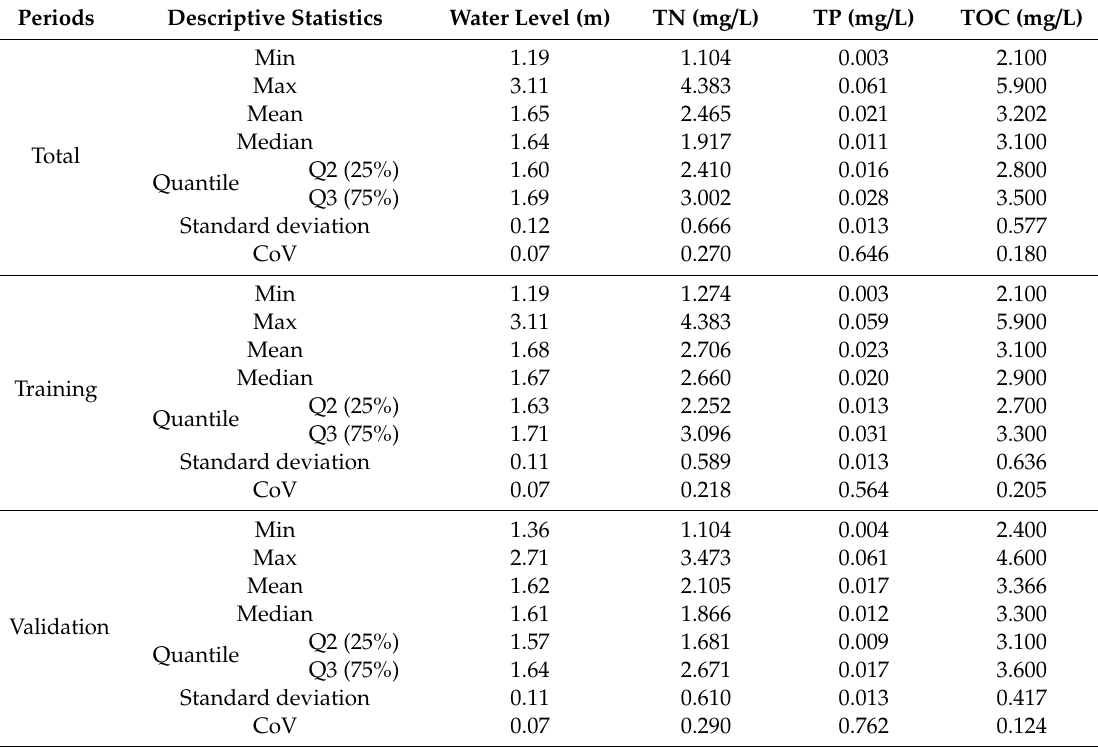
Table 1. Descriptive statistics of water level, total nitrogen (TN), total organic carbon (TOC), and total phosphorus